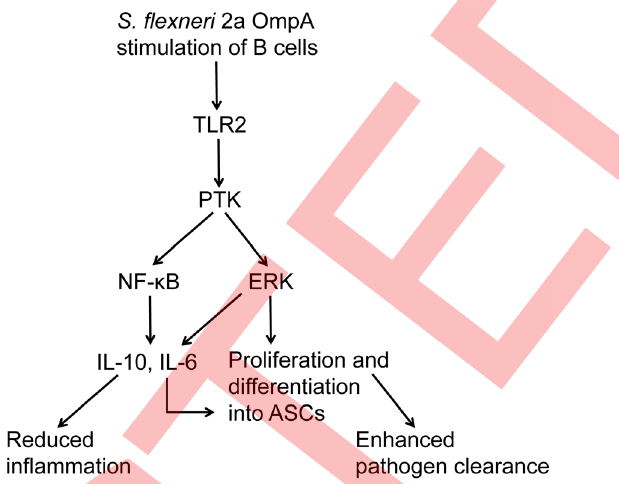
Figure 9. A hypothetical model for S. flexneri 2a OmpA- mediated activation of B cells and its role in regulation of host immune response.